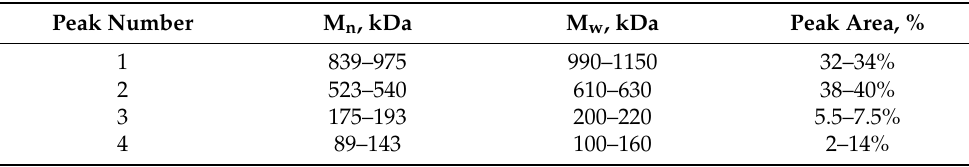
Table 2. Molecular weight distribution of sodium